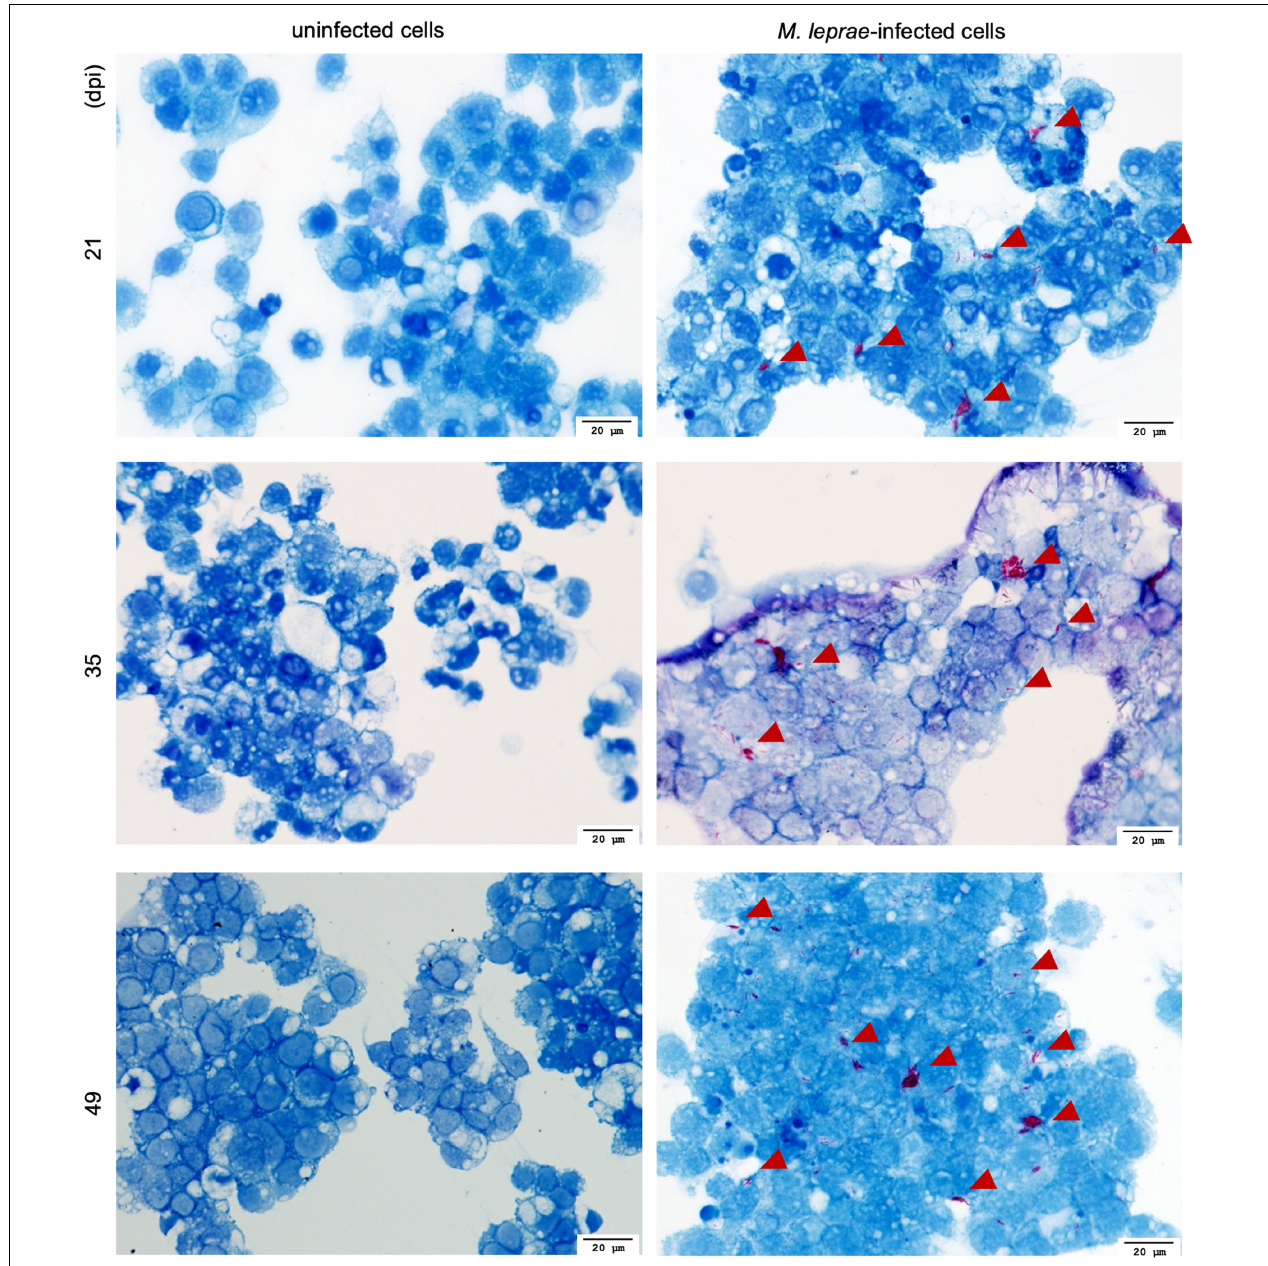
FIGURE 2 | Fite’s Acid fast staining of M. leprae Thai-53 strain-infected cells visualization by light microscopy. ISE6 cells were infected with M. leprae Thai-53 strain and observed under light microscope at magnification 40 × after being stained with Fite’s acid-fast staining at 21, 35, and 49 dpi. Bacilli are shown in red and indicated by